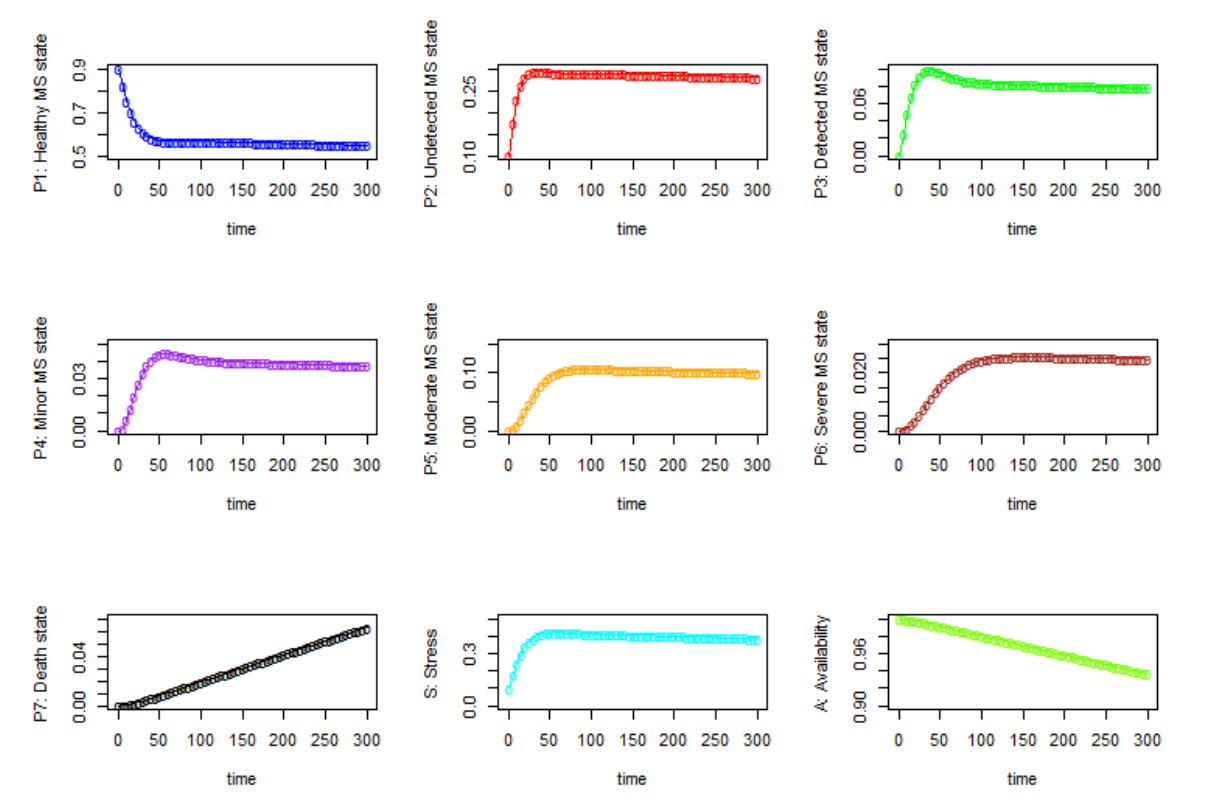
Figure 2. The probability results of each state for Case 1, where the initial probabilities are P 1 (0) = 0.9, P 2 (0) = 0.1. The probability that a person is stressed, either undetected or detected, (state S) significantly increases at the beginning and then continues to increase until around the 40th unit time. The probability of a person dying from stress follows an increasing function and is about 6.30% at time 300. The results from Table 3 and Figure 3 show that there are strong positive correlations between state S 4 and S 5 with 0.94, S 2 and S 3 with 0.96, and S 5 and S 6 with 0.94. Similarly, there are strong negative correlations between S 1 and S 2 with − 0.91, S 1 and S 4 with − 0.94, and S 1 and S 5 with − 0.92. Figure 4 shows the results of each state, where the initial value P 1 (0) = 1. Table 3. The correlation results of the system state for Case 1 ( k = 0.005, v = 0.001, w =